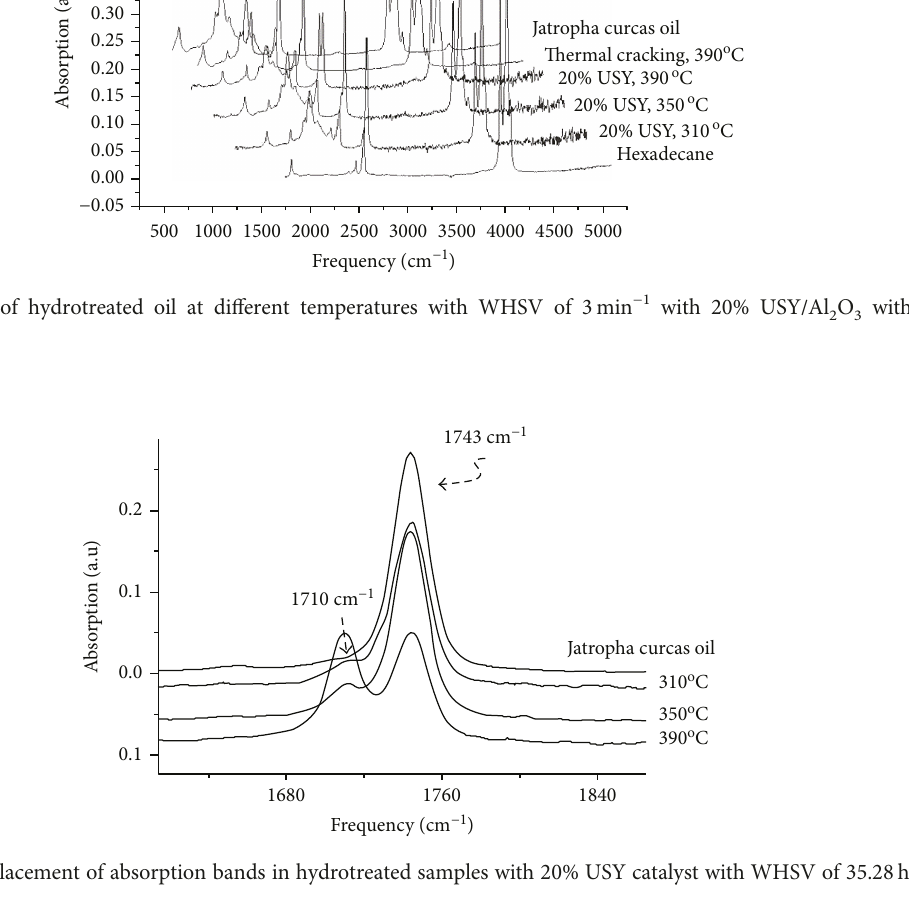
Figure 4: Displacement of absorption bands in hydrotreated samples with 20% USY catalyst with WHSV of 35.28h − 1 .